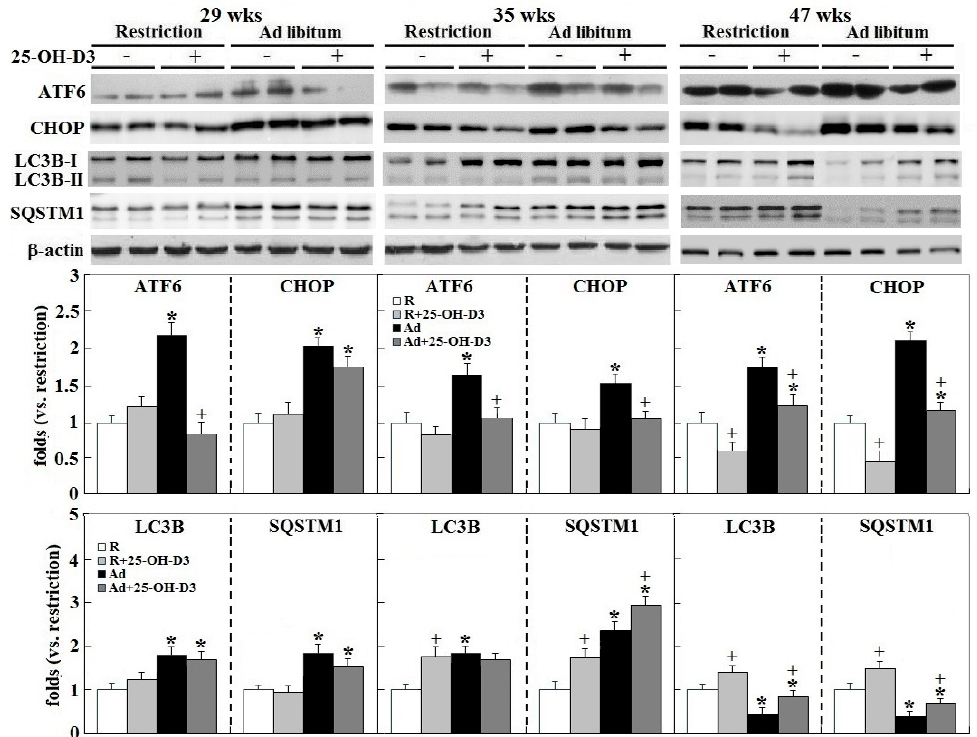
Figure 5. E ff ects of dietary 25-hydroxycholecalciferol supplementation on cardiac endoplasmic reticulum (ER) stress and autophagy of broiler breeder hens provided with restricted or ad libitum feed intake. ER stress and autophagy analysis includes activating transcription factor 6 (ATF6), CCAAT box binding enhancer homologous protein (CHOP), microtubule-associated protein 1 light Chain 3 beta (LC3B), and Sequestosome 1 (SQSTM1) by Western blot method ( n = 4 for each group). Densitometric intensity results were normalized to β -actin and expressed as ratios relative R-hens at 29, 35, or 47 wks. *; significant di ff erence by Ad-feed intake (vs. corresponding R hens, p < 0.05). + ; significant di ff erence by 25-OH-D 3 (vs. R or Ad hens, p <